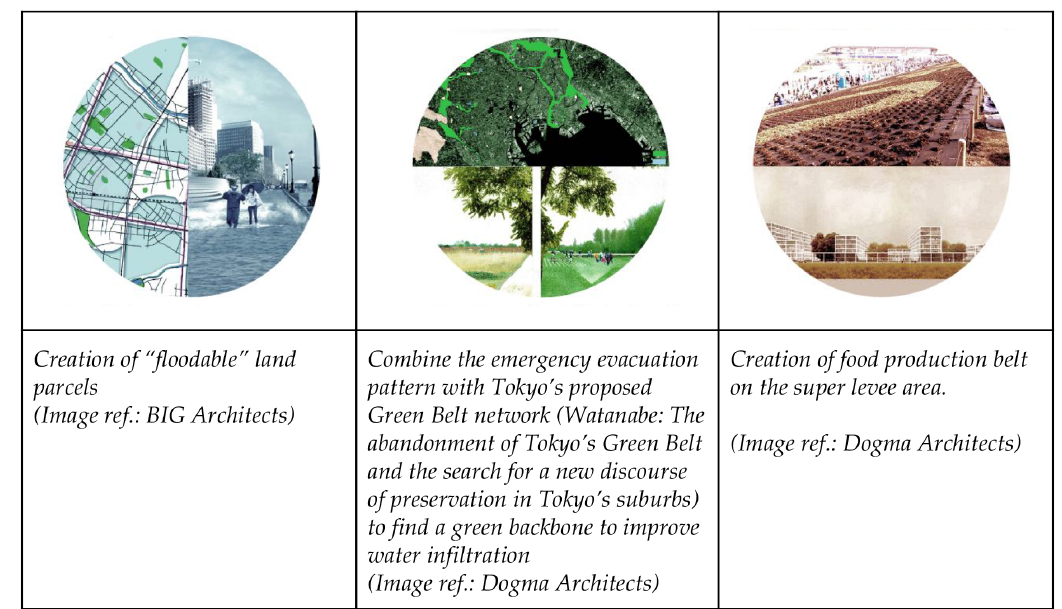
Figure 13. Design features of Strategy B (pro super